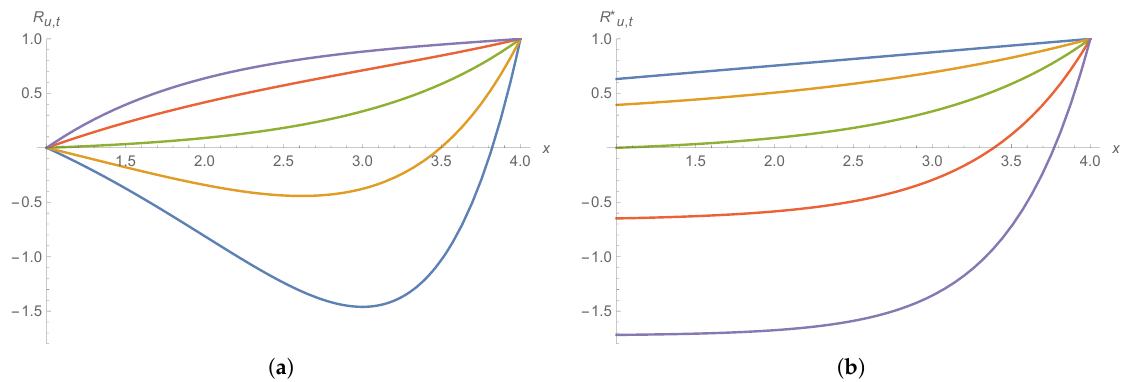
( x ) ( b ) as functions of x , with u = 1, t = 4, and λ = 0.001, 0.5, Figure 5. Functions R u , t ( x ) ( a ) and R ∗ u , t 1, 1.5, 2 (from bottom to top on the left, and viceversa on the